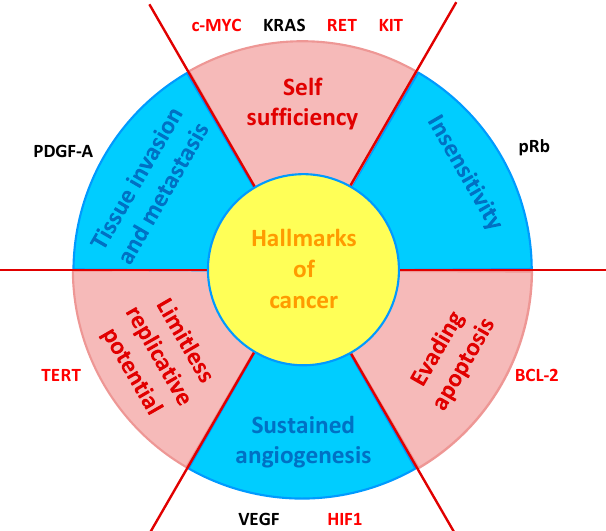
Figure 7. Schematic representation of the six hallmarks of cancer [67], in relation with genes containing G4s in their promoters. Gene marked in red are targeted by one or more NDIs described in this session (adapted from [68] ).